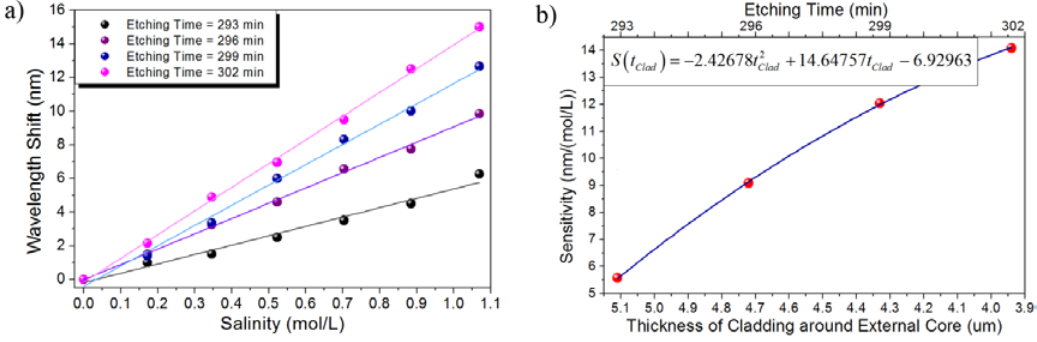
Figure 9. Salinity, low-concentration regime: ( a ) Absolute wavelength shift of the sensor response; ( b ) Sensitivity of the TCF sensor as a function of the remaining